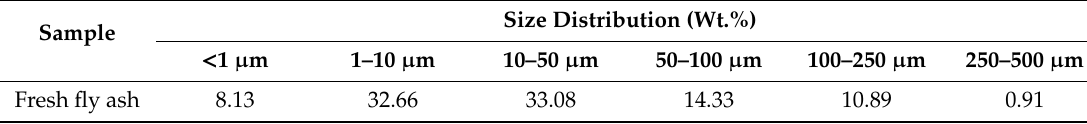
Table 2. Particle size distribution (wt. %) of the fly ash